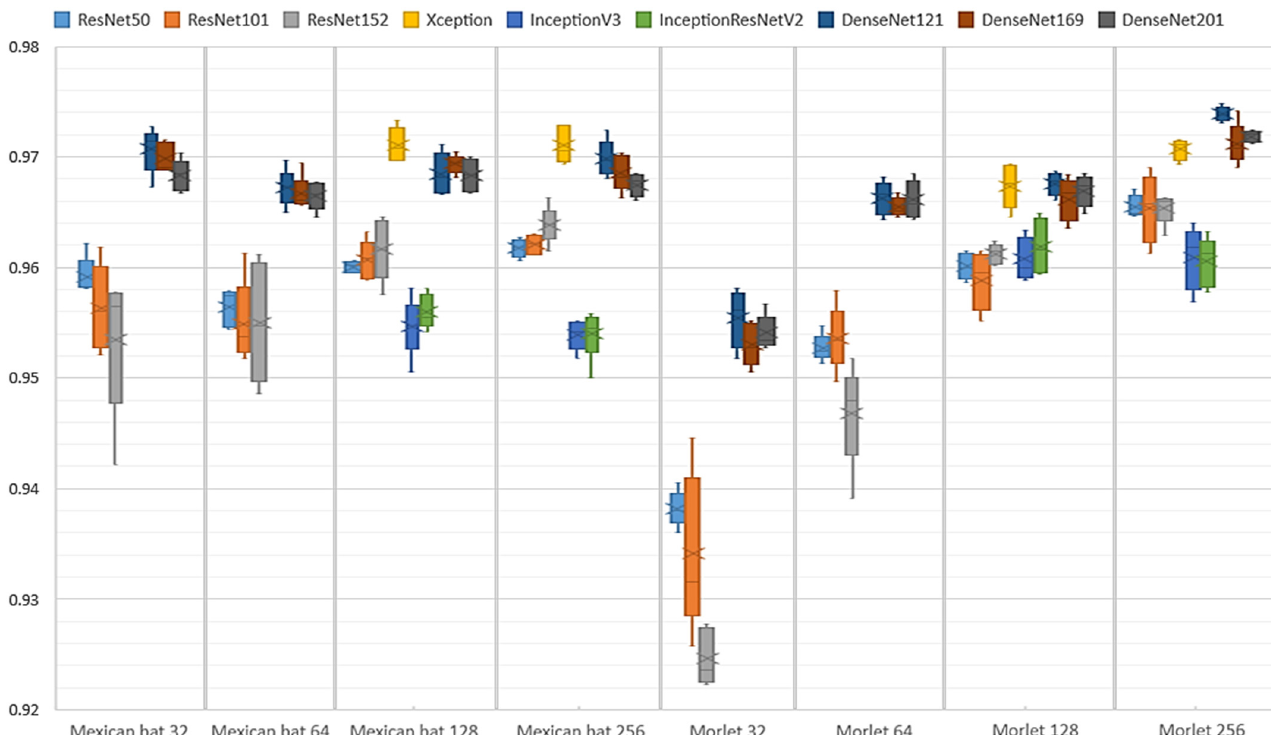
Figure 4. The classification accuracy results of five tries for each tested combination.